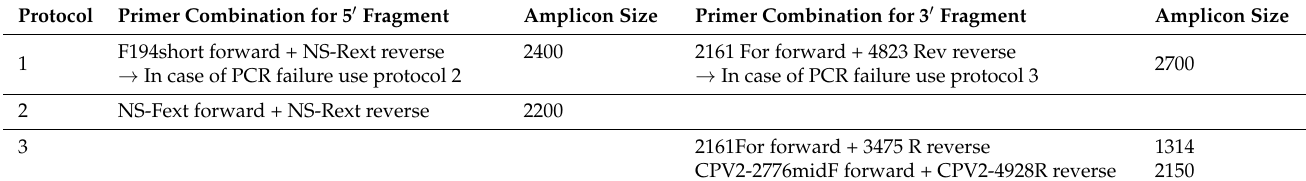
Table 2. Protocols used for sequencing the complete genome of Carnivore protoparvovirus 1